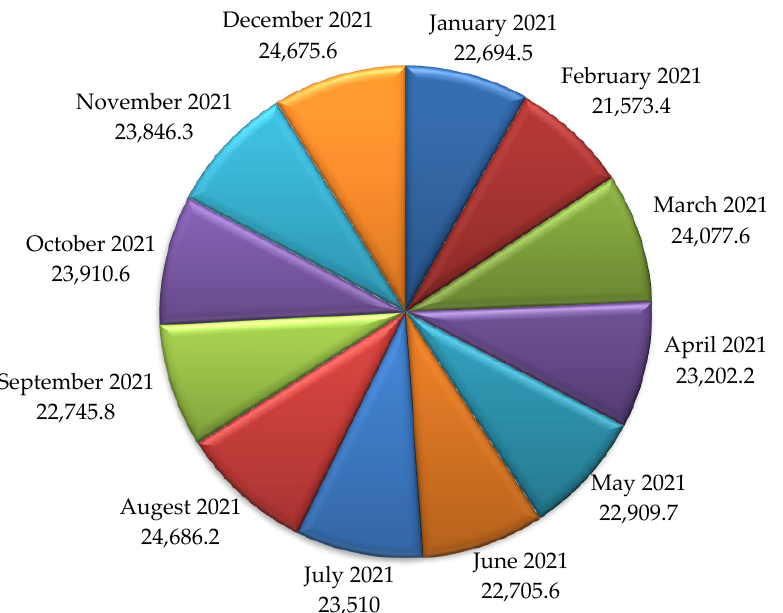
Figure 5. Primary oil refining at Russian refineries from January 2021 until December 2021, (thousands of tons) [78].